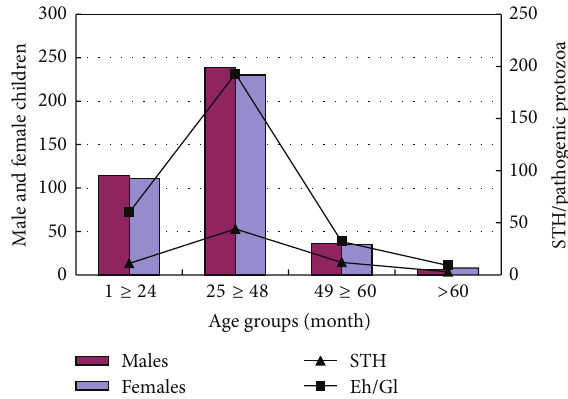
Figure 2: Soil-transmitted helminths (STHs) and pathogenic proto- zoan parasites among male and female children participants. STHs: soil-transmitted helminthes; Eh/Gl: Entamoeba histolytica / Giardia